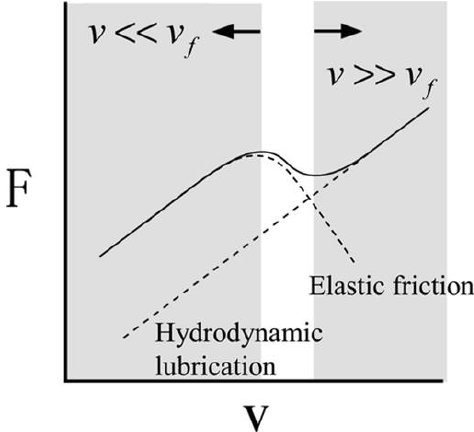
Figure 4. Schematics for the velocity dependence of the friction force at an adhesive contact between a hydrogel and a solid surface according to the elastic-hydrodynamic model. The model distinguishes three regimes: if the sliding velocity 𝑉 ≪ 𝑣 𝑓 , the frictional force is due to the elastic energy of stretched polymer chains dissipated upon rupture, and it increases with the sliding velocity. If the sliding velocity is high enough ( 𝑉 > 𝑣 𝑓 ) the polymer does not have enough time to adsorb to the solid surface, and the friction force decreases with increase in velocity. At very high sliding velocities ( 𝑉 ≫ 𝑣 𝑓 ), the onset of hydrodynamic lubrication is proposed. Reproduced from Ref. [50], Copyright 2005 with permission from ACS publications.